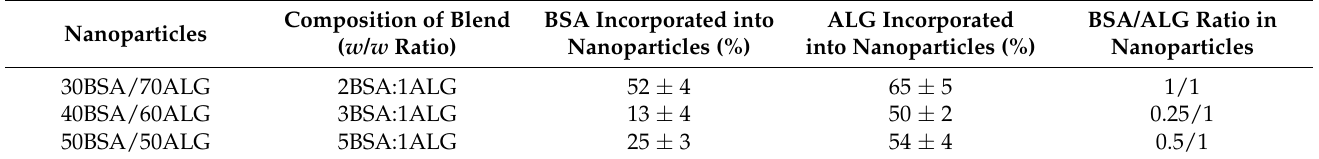
Table 1. Nanoparticle composition. Percentage of each polymer incorporated into nanoparticles. BSA/ALG ratio in nanoparticles. Composition of Nanoparticles